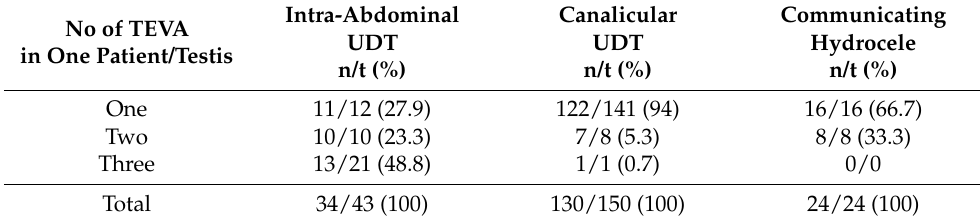
Table 3. Distribution and number of TEVA per one gonad and one patient.